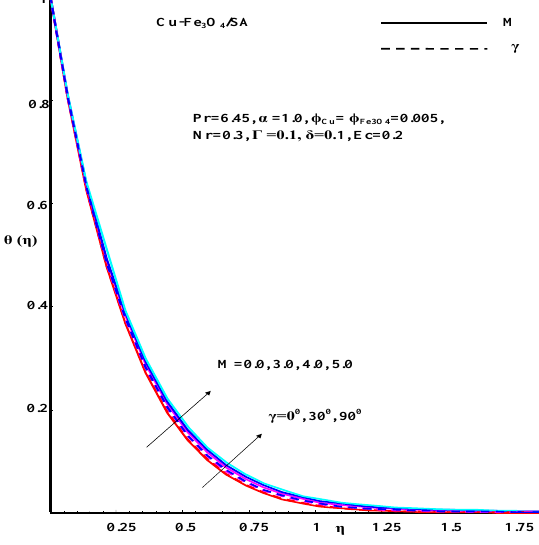
Figure 7. Effect of M and inclined angle parameters on temperature